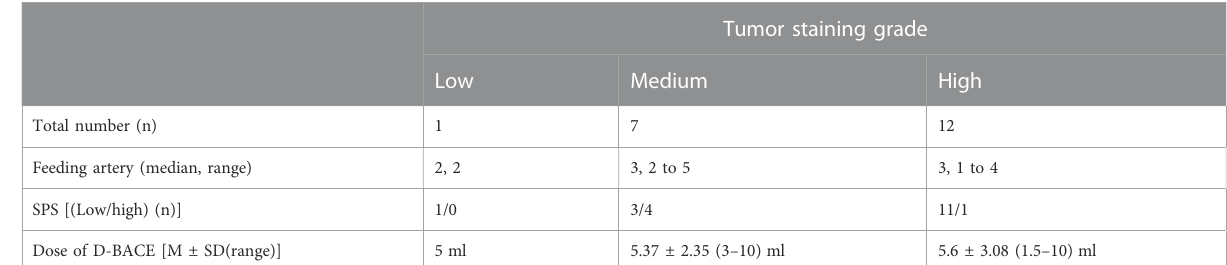
TABLE 3 DEB-BACE treatment.